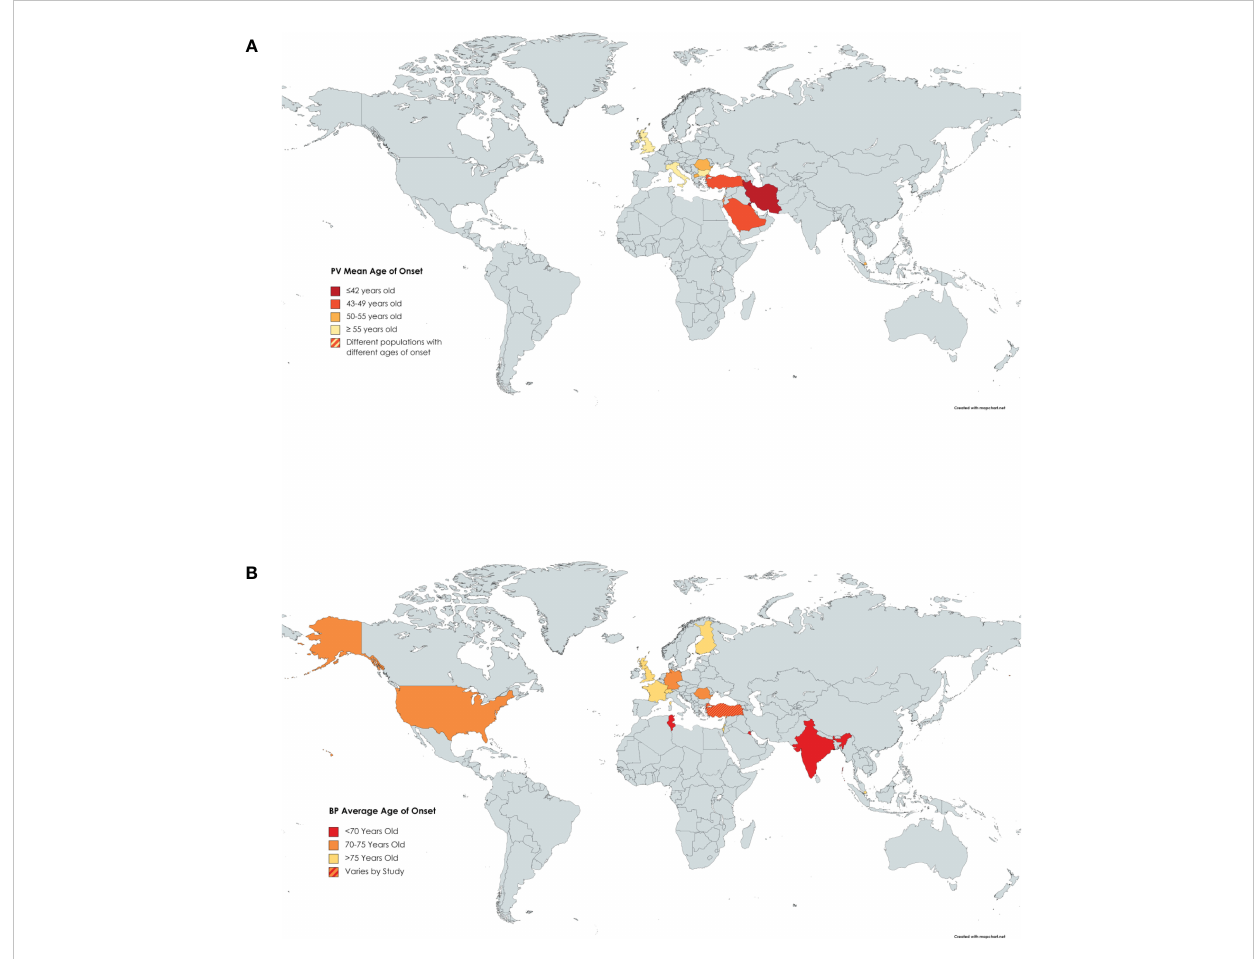
FIGURE 4 Age of Onset of PV by Country. Darker shading signi fi es a younger age of onset of (A) PV or (B) BP. Countries with more than one shaded color signify that more than one study had results that fell into different